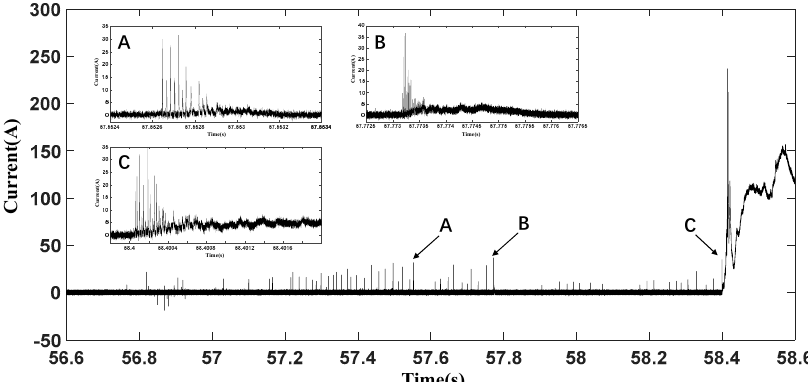
Figure 4. Current waveform and partially enlarged view of triggered lightning 570. ( A – C ) Enlarged waveform of three IPCPs.